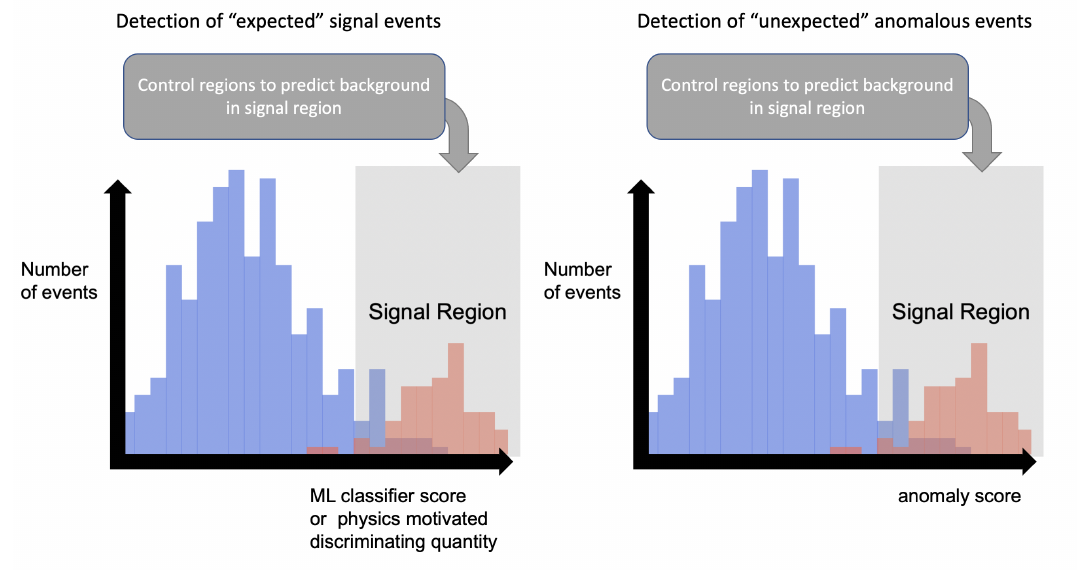
Figure 1: Illustration of the strategies for defining signal regions with different tra- ditional approaches (left picture) and the anomaly score proposed and examined in this article (right picture). The same histogram is used to emphasize the similarity of the strategies, however, we do not expect the strategies to yield the exact same